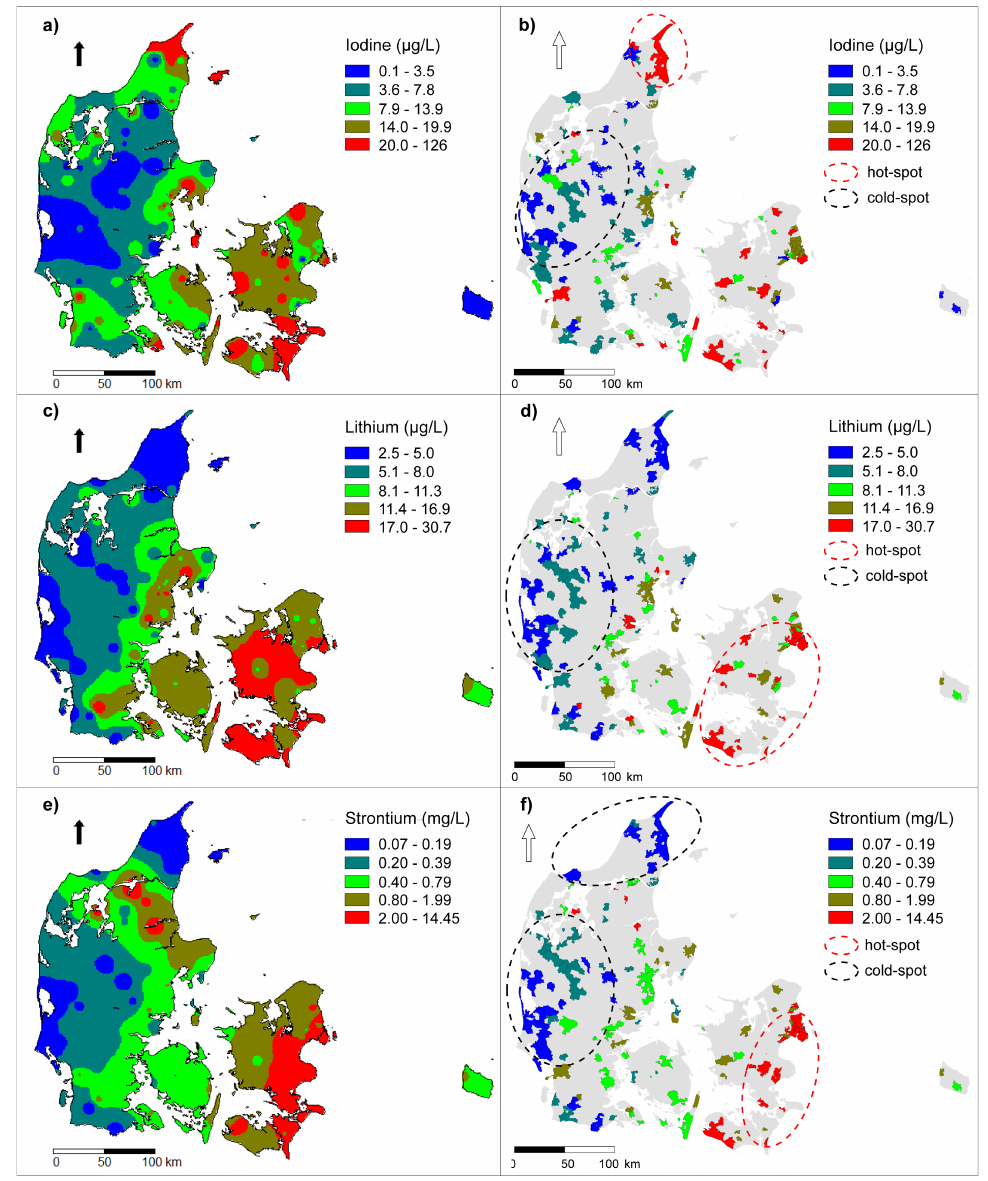
Figure 3. Iodine, lithium, and strontium in drinking water in Denmark; ( a , c , e ) IDW interpolation; ( b , d , f ) drinking water concentrations in the selected supply areas and hot and cold spot clusters. Note: each category represents ~20% of the observations; the cluster analysis is based on the point data. See Section 2 for